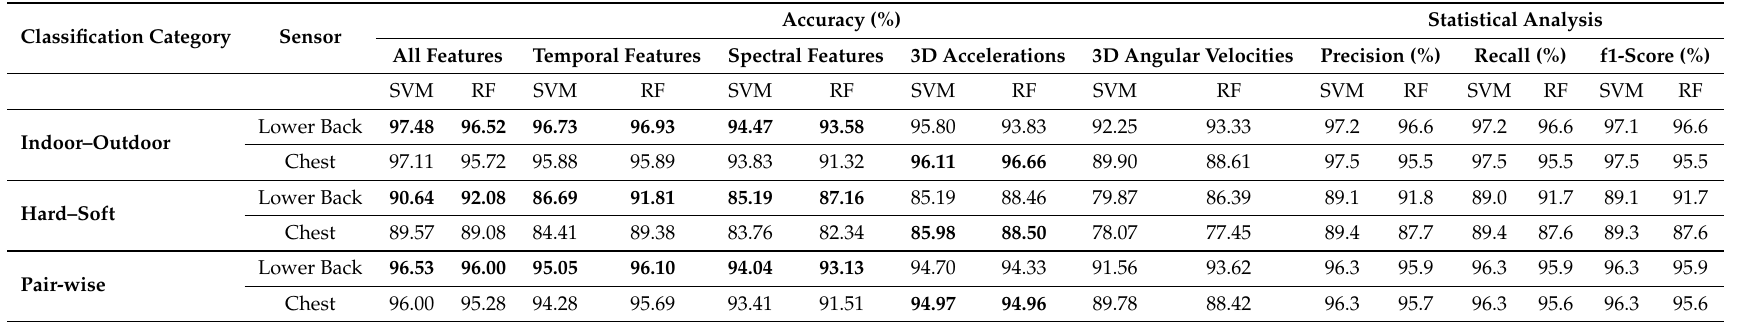
Table 6. Classification results of binary classification: indoor–outdoor, hard–soft and pair-wise classification for each sensor location. The classification results are presented for each feature set and statistical scores are presented for the set of all features